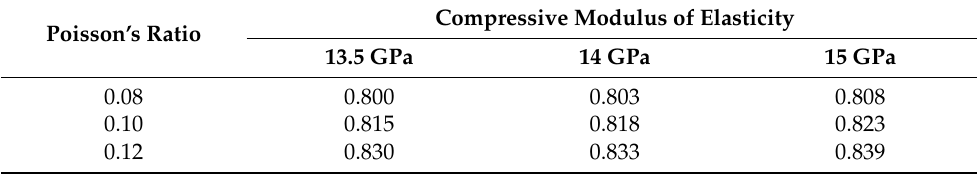
Table 7. Tensile stress corresponding to different Poisson’s ratio and compressive elastic modulus Table 6. Tensile stress corresponding to different Poisson’s ratios and compressive elastic moduli of of anhydrite self-leveling mortar layer. sand-free gypsum self-leveling mortar layer.